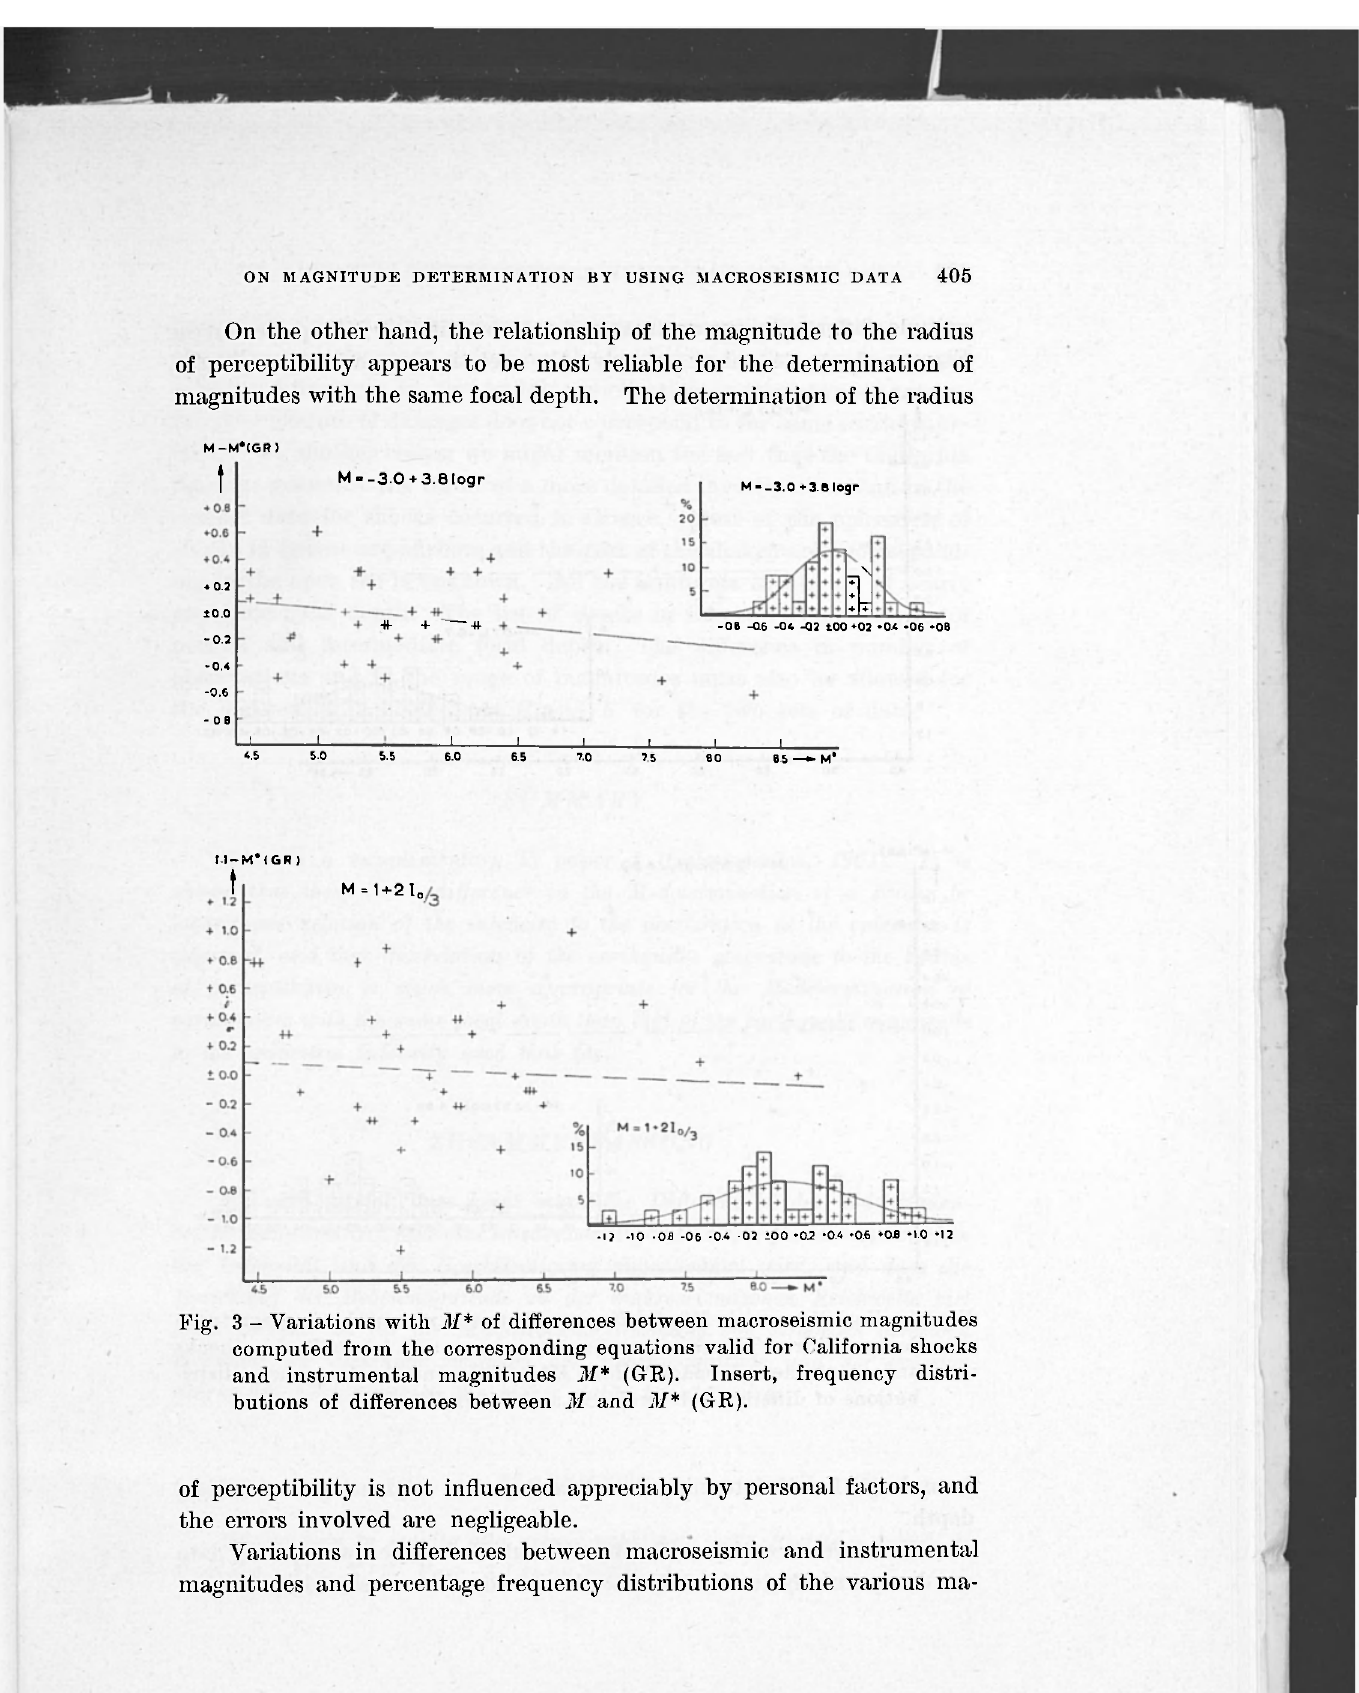
Fig. 3 - Variations with ìli* of differences between macroseismic magnitudes computed from the corresponding equations valid for California shocks and instrumentai magnitudes M* (GR). Insert, frequency distri - butions of differences between M and M*